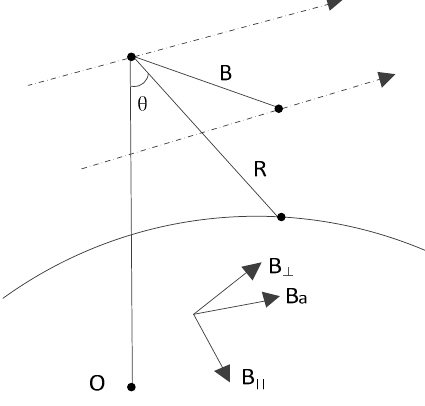
Figure 3. Baseline decomposition manner.